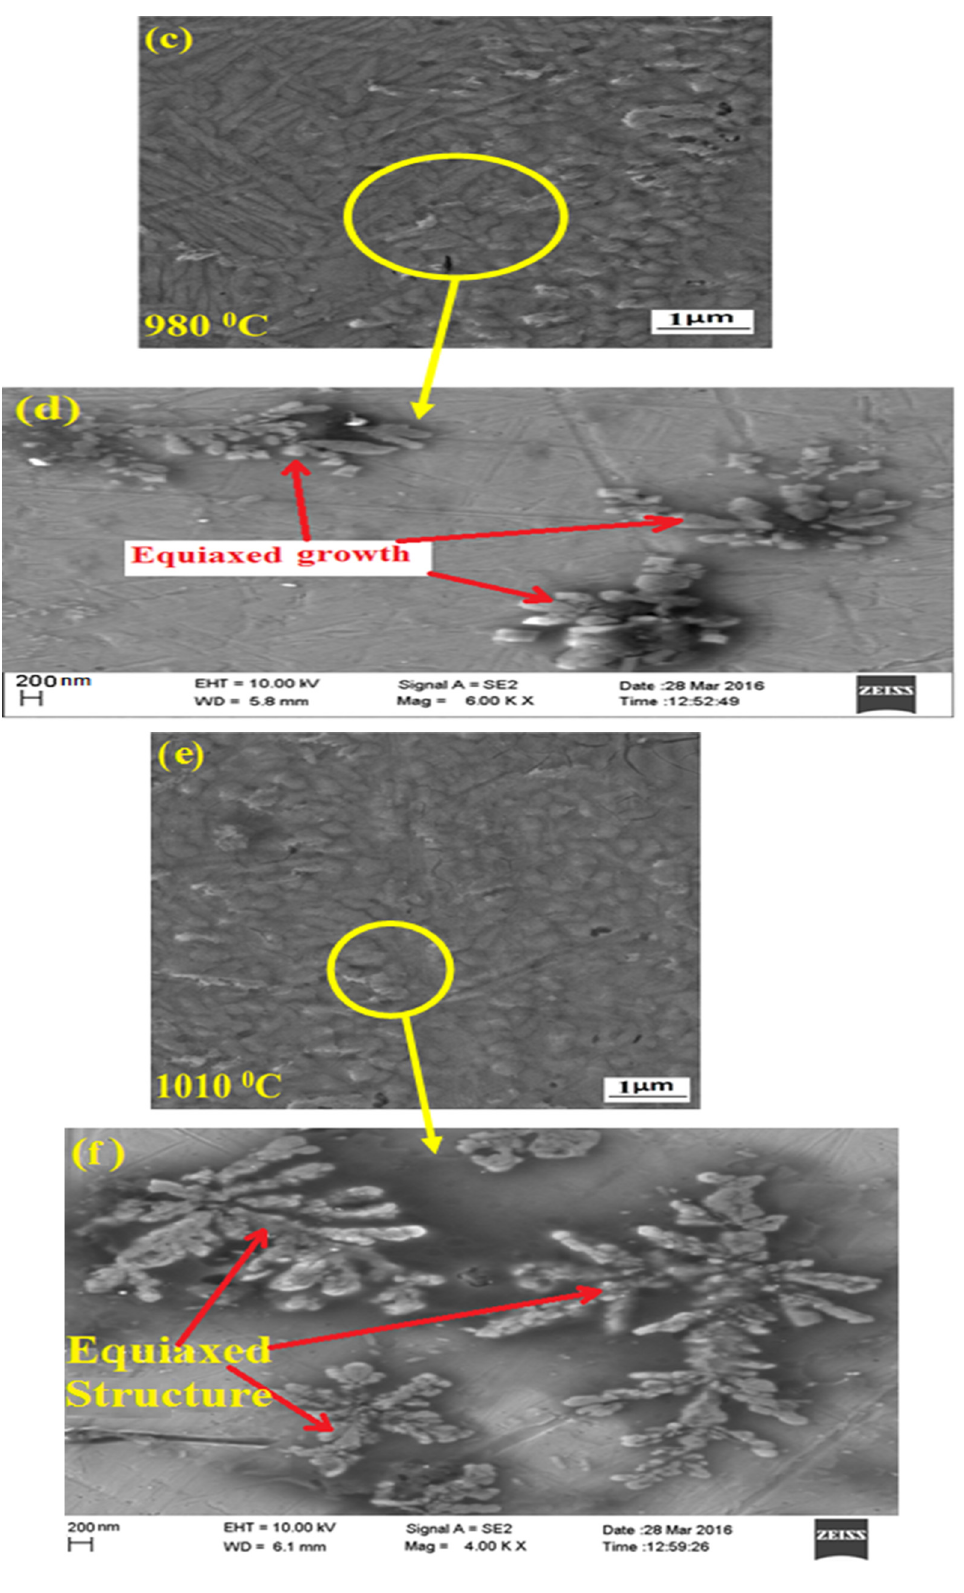
Figure 7. Structure at different temperatures during annealing. ( a ) Base Sample ( b ) at 950 ◦ C ( c ) at 980 ◦ C; ( d ) large view of equiaxed structure growth ( e ) at 1010 ◦ C; ( f ) close view of an equiaxed structure [17,18].